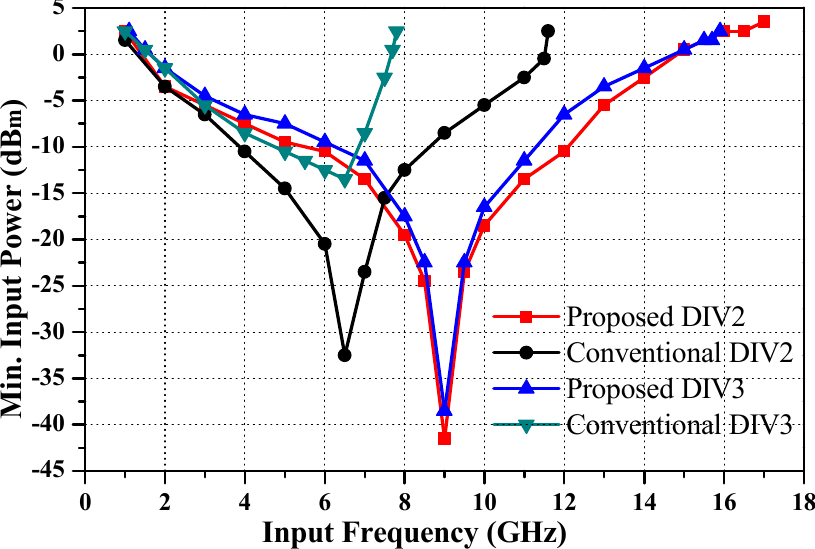
Figure 8. Measured input sensitivity curves of the conventional and proposed divide-by-2/3 prescalers.